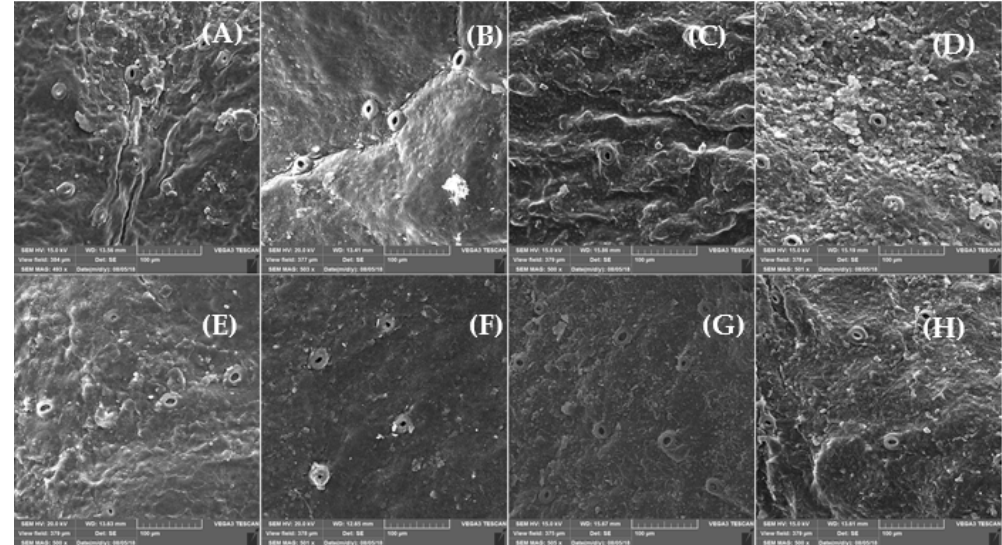
Figure 2. Scanning electron micrographs (500 × magnification) of the flavedo of blood orange cultivars after 180 days of cold storage plus 2 days at 20 °C; ( A ) ‘Moro’ at 2 °C; ( B ) ‘Tarocco’ at 2 °C; ( C ) ‘Sanguinello’ at 2 °C; ( D ) ‘Sanguine’ at 2 °C; ( E ) ‘Moro’ at 5 °C; ( F ) ‘Tarocco’ at 5 °C; ( G ) ‘Sanguinello’ at 5 °C; ( H ) ‘Sanguine’ at 5 °C.